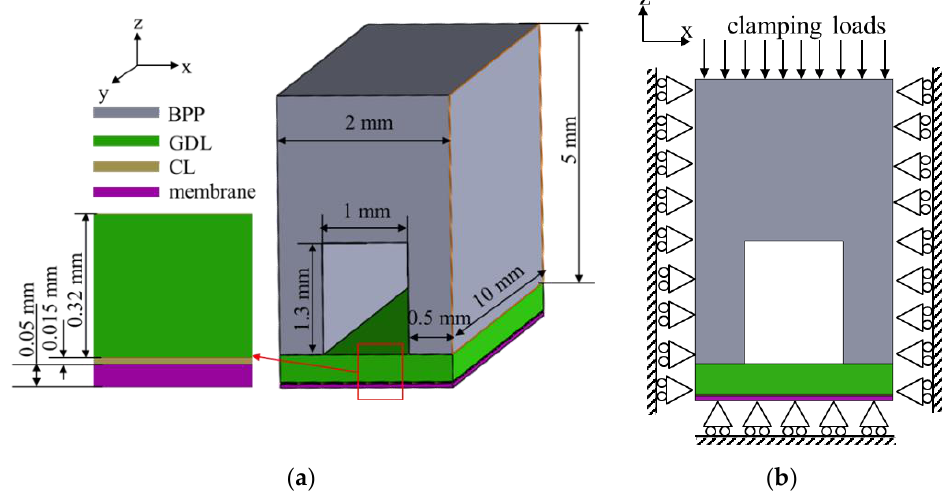
Figure 6. A simplified PEMFC unit cell in ( a ) and defined boundary conditions in ( b ). As given in Figure 7 Error! Reference source not found. , the maximum stress concen- tration of the two models (the linear and isotropic and the 3-D nonlinear and orthotropic constitutive models of GDLs) occurs at the same location where the gas channel ribs con- nect to the GDL, similar to the findings in [24]. Significantly, the magnitude of the maxi- mum stress obtained by the two models of GDLs is quite different from each other. Even though the maximum stress concentration happens at the same place, the value of the maximum stress in the 3-D nonlinear and orthotropic model is nearly 10 times larger than that of the linear and isotropic model. In summary, the numerical models closer to their actual material properties should be characterized comprehensively and thoroughly, and the nonlinearity and orthotropy in the mechanical performance of GDLs must be taken into consideration for a reliable stress simulation and prediction of fuel cells. ( a ) ( b ) Figure 7. Stress distribution of a simplified PEMFC unit cell by a linear and isotropic model of a GDL in ( a ) and a 3-D nonlinear and orthotropic constitutive model in ( b ).